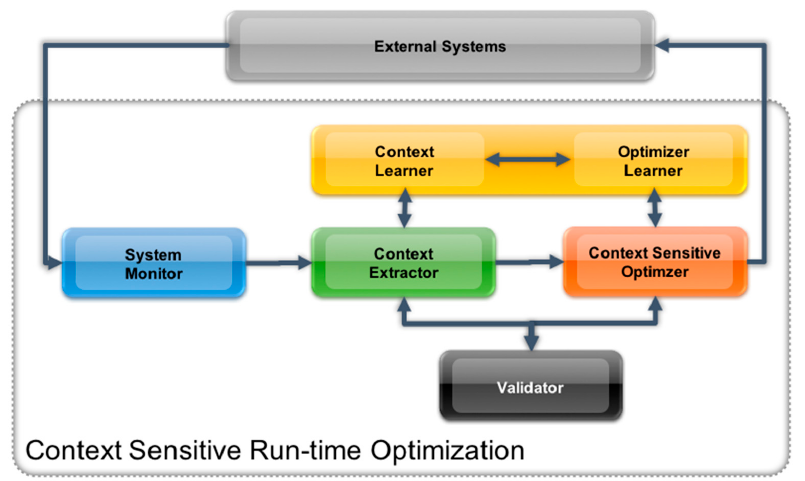
Figure 2. “Reference” Architecture to achieve context sensitivity for manufacturing systems.